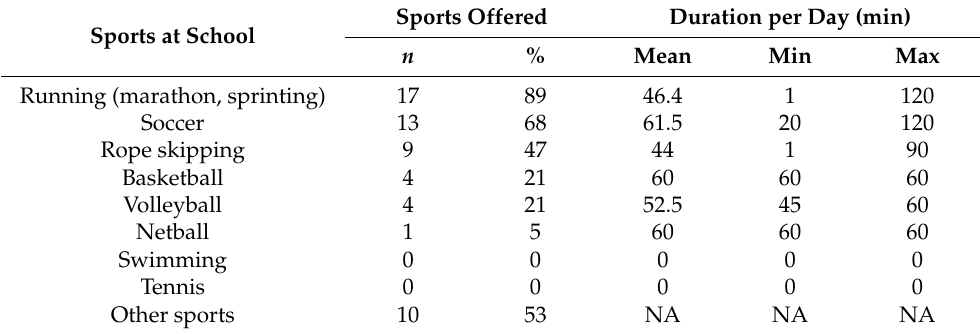
Table 4. Offered sports and their duration per day in junior secondary schools as reported by the